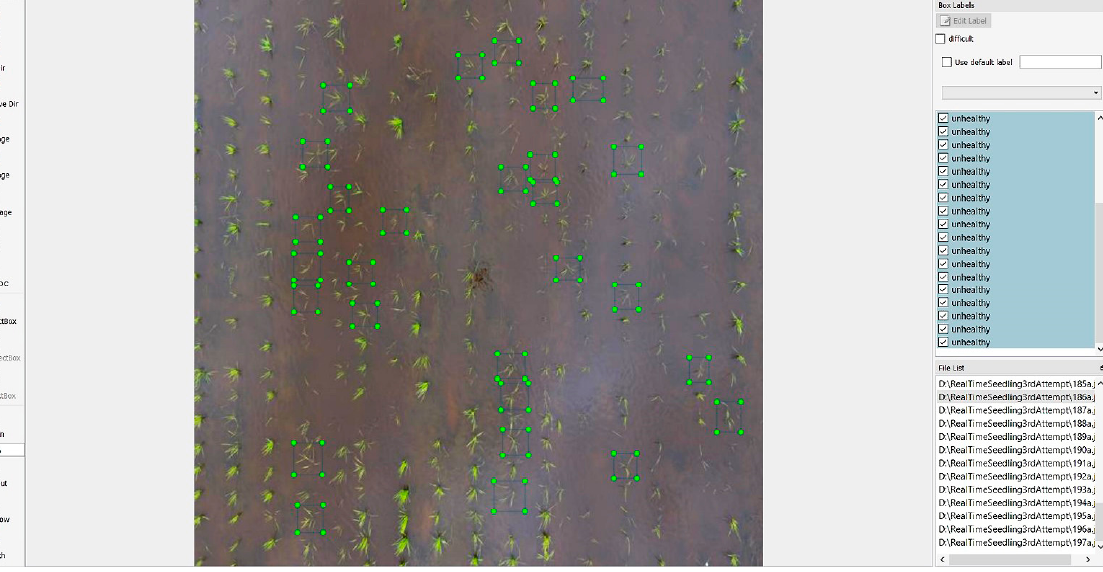
Figure 2. The process of data annotations using labelImg Software .